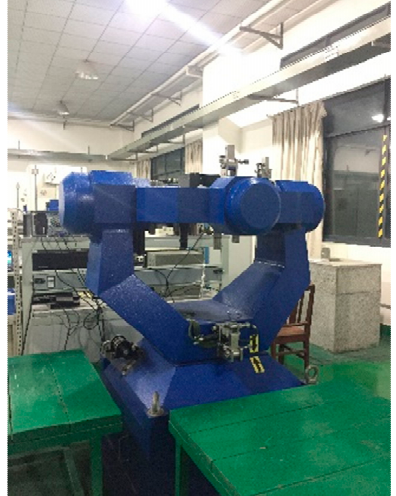
Figure 6. The high-precision 3-axis turntable. Sensors 2019 , 19 , x FOR PEER REVIEW